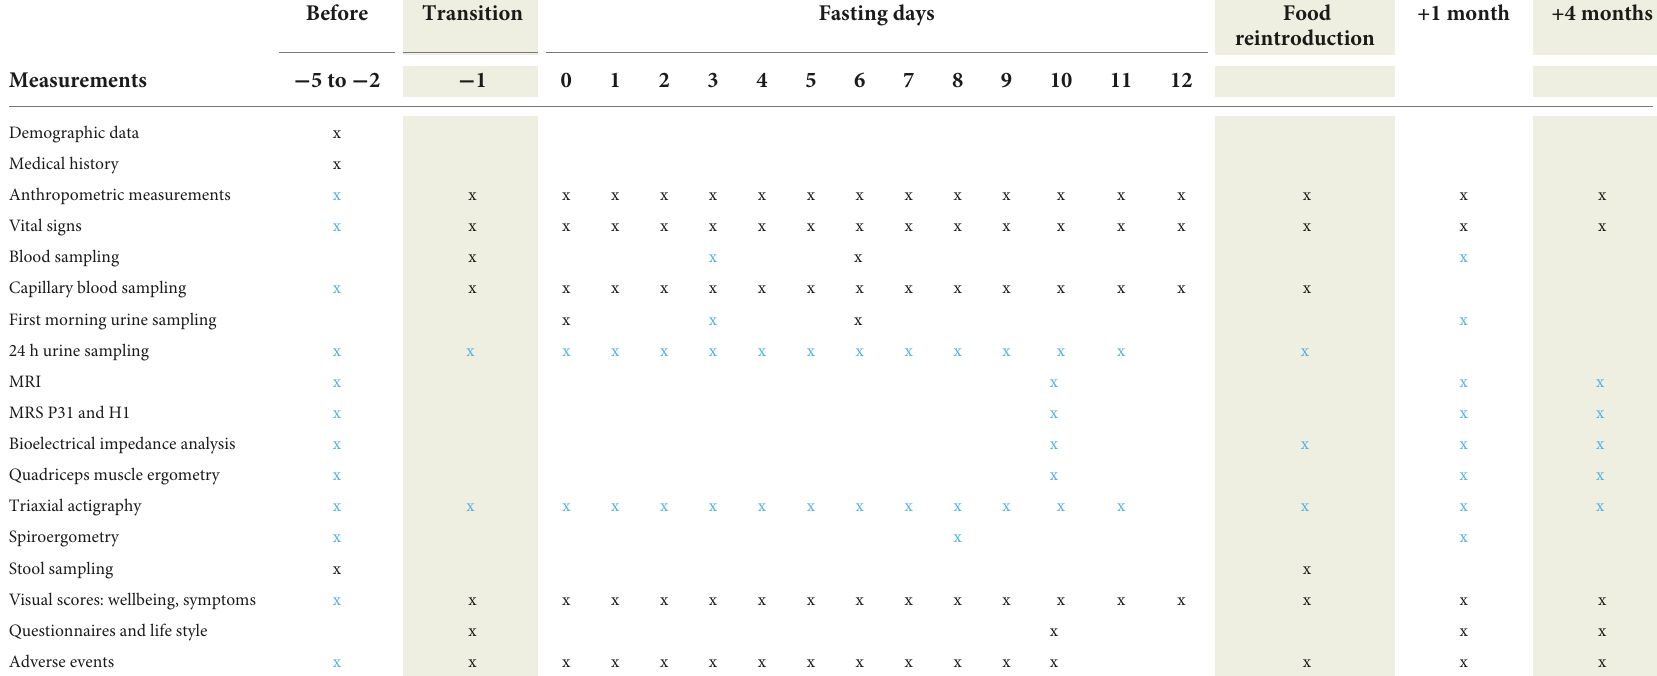
TABLE 2 Summary of measurements.